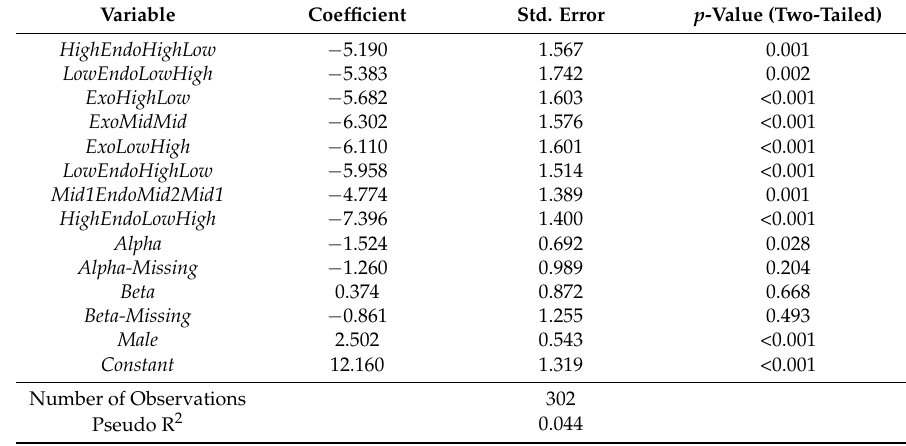
Table 5. Tobit Regression of Investment (reference category for treatment is Mid1EndoMid1Mid2